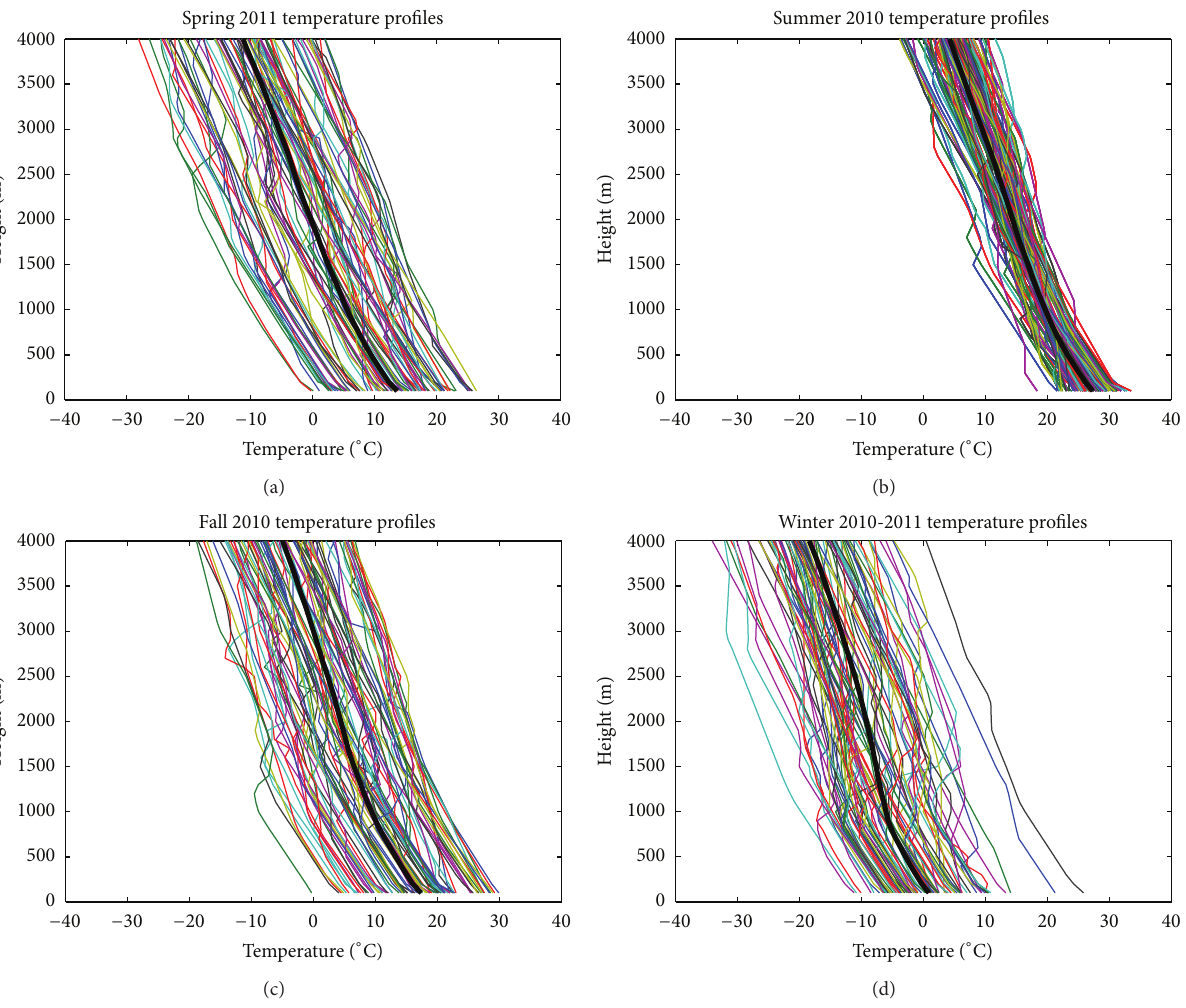
Figure 3: Spaghetti plots for vertical temperature profiles (colored lines) and their mean (thick black line) from 06UTC (15LST) radiosonde observations at Osan in four seasons during the period June 2010–May 2011. Spring 2011 (a), summer 2010 (b), fall 2010 (c), and winter 2011 (d) had 92, 92, 88 (3 missing data), and 90 profiles,